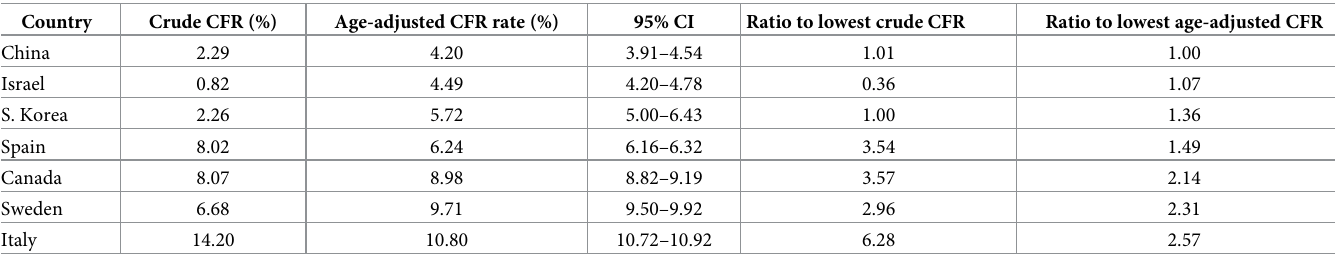
Table 2. Crude and age standardized (95%CI) case-fatality rates (CFR,%) for COVID-19 in seven countries. Country Crude CFR